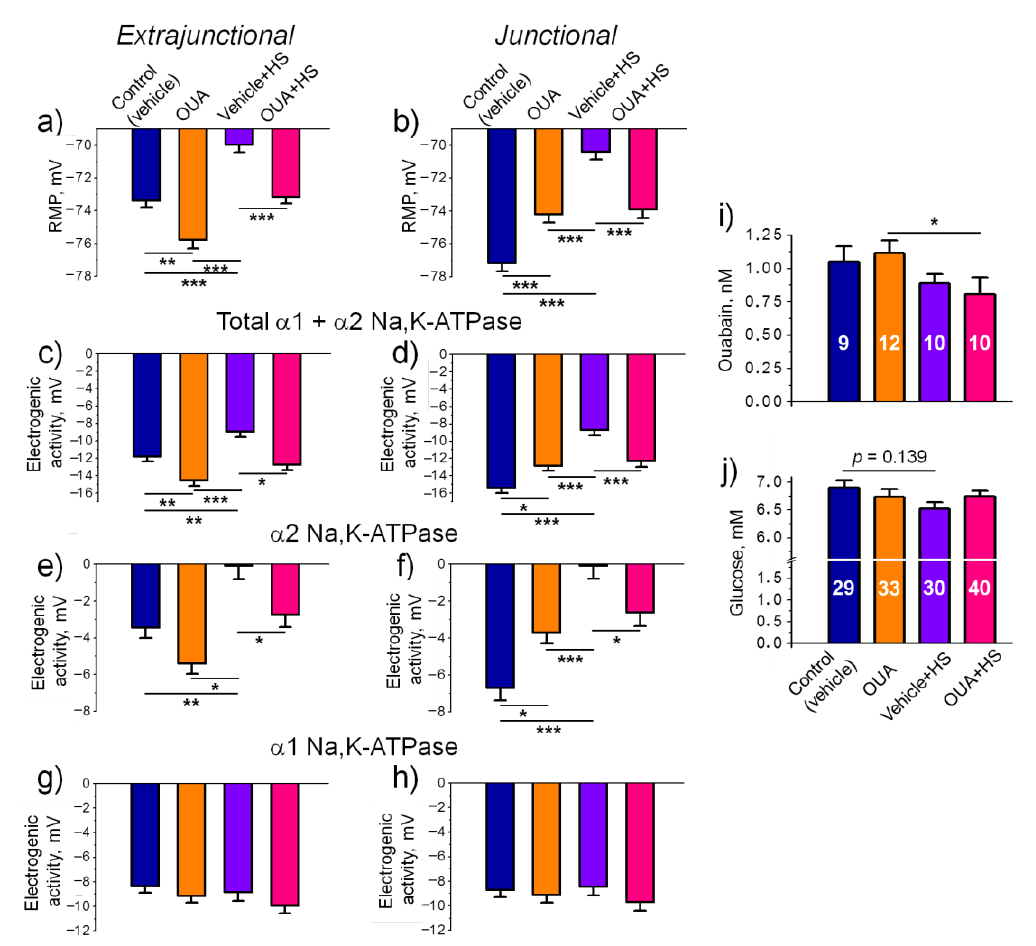
Figure 3. Changes in the electrogenesis of soleus muscles after 4-days pre-treatment with ouabain (1 µ g/kg) followed by rat hindlimb suspension (HS) for 6 h. ( a , b ) Resting membrane potential (RMP). ( c , d ) Total electrogenic activity contributed by the α 1 and α 2 isozymes of Na,K-ATPase. ( e , f ) Electrogenic activity of the α 2 isozyme of Na,K-ATPase. ( g , h ) Electrogenic activity of the α 1 isozyme of Na,K-ATPase. The measurements in ( a – g ) extrajunctional and ( b – h ) junctional regions of the membrane, as indicated. ( i , j ) Serum level of ouabain and glucose, respectively (the number of rats is shown in the bars). Control and ouabain-treated (OUA) groups are represented by the rats, which received injections of vehicle (0.9% NaCl) or ouabain for 4 days, respectively. HS group contains the rats injected by 0.9% NaCl followed by HS for 6 h. OUA + HS group is a group of ouabain-injected rats that were exposed for the following 6-h HS. Each value is a result of measuring the RMP in at least 100 muscle fibers of 6–10 muscles from 3–5 rats. There was a significant interaction between HS and OUA effects for ( b ) p < 0.0001; F (1.614) = 42.15; ( d ) p < 0.0001; F (1.596) = 24.64 and ( f ) p < 0.0001; F (1.596) = 16.97. Two-way ANOVA followed by Tukey’s multiple comparisons test. * p < 0.05, ** p < 0.01, *** p < 0.001—compared as indicated by horizontal